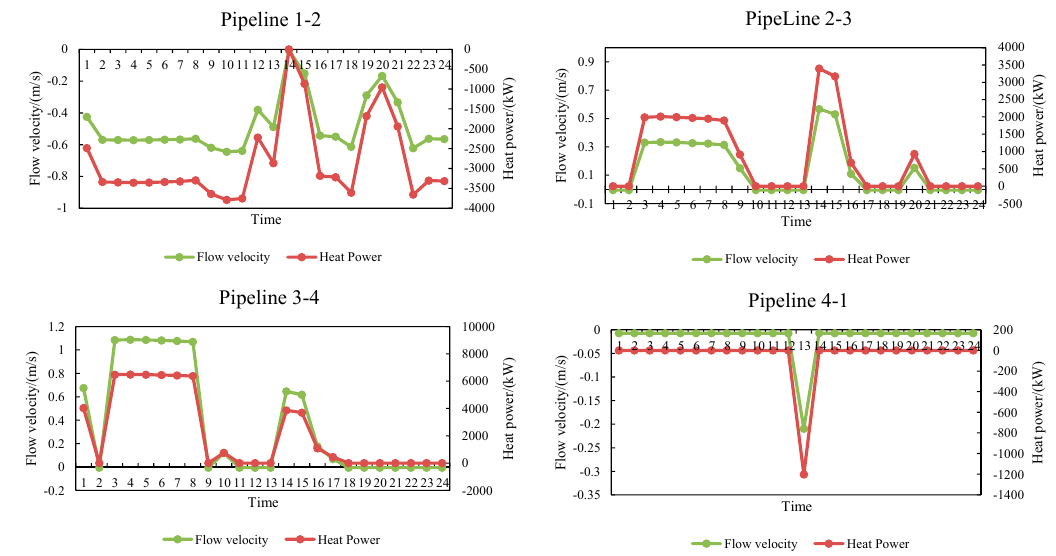
Figure 11. Flow velocity and thermal power of the heating medium in the heating network.